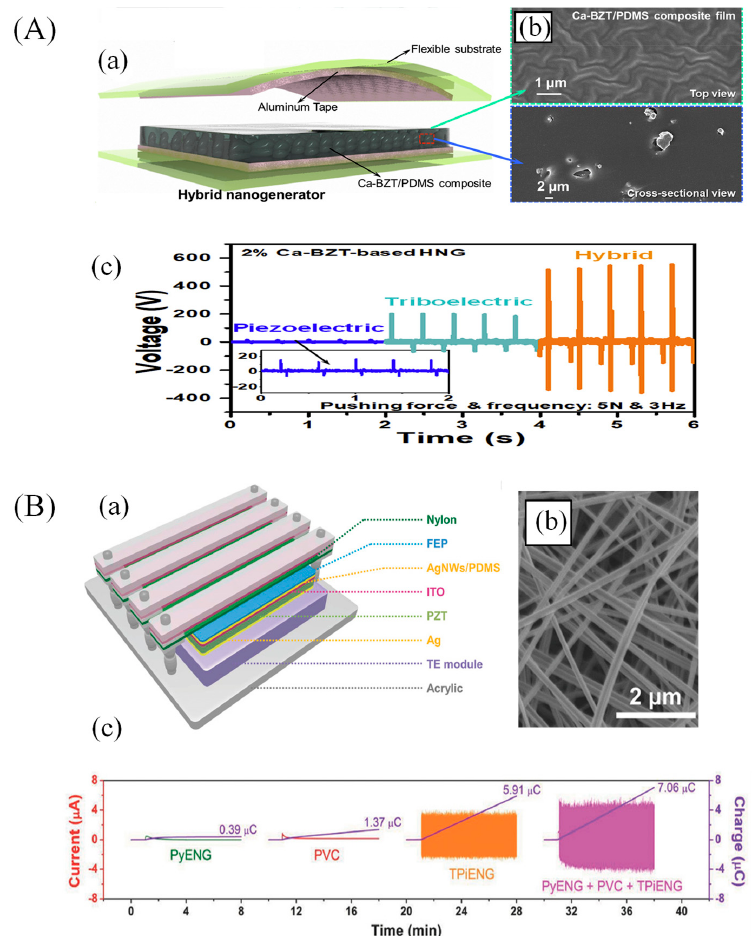
Figure 10. ( A ) A Ca-doped BaTiO 3 -based composite piezo-tribo hybrid nanogenerator. ( a ) Schematic diagram of BaTiO3-based hybrid nanogenerator. ( b ) Top and cross-sectional FE-SEM view of Ca- BaTiO 3 /PDMS composite film. ( c ) Comparison of output performance of a fabricated nanogenerator operating in piezoelectric, triboelectric, and hybrid modes [122]. Adapted with permission